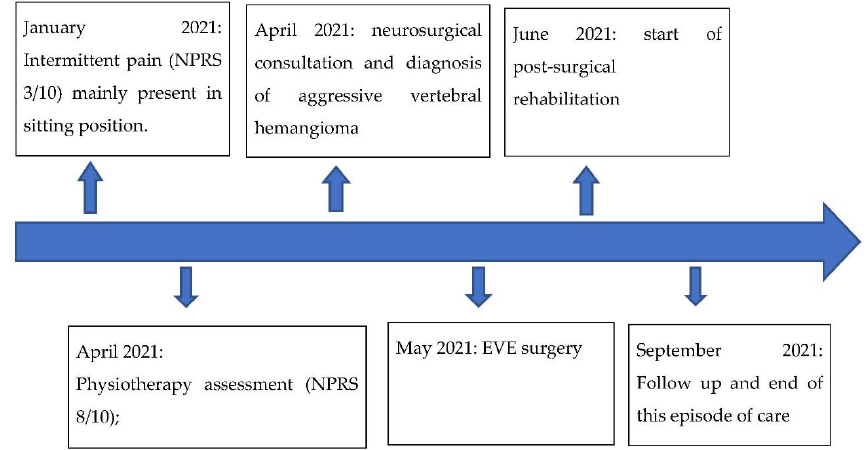
Figure 1. Timeline. Acronyms: NPRS , Numeric Pain Rating Scale; EVE , Endovascular Embolization.